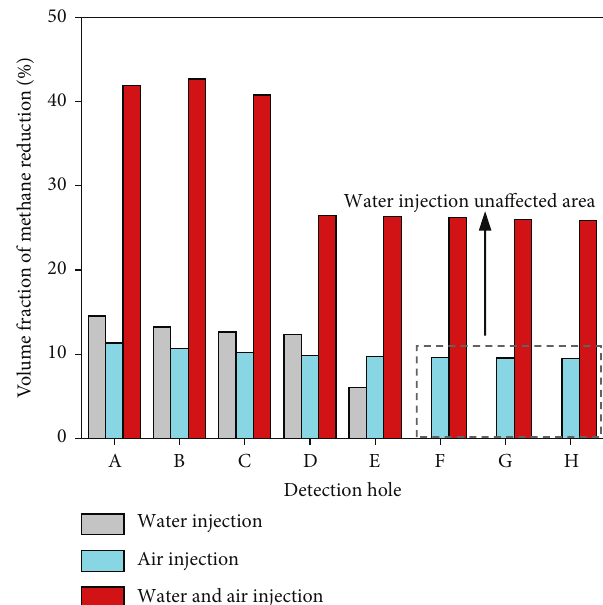
Figure 14: V reduction at each detection point under three displacement methods. CH 4